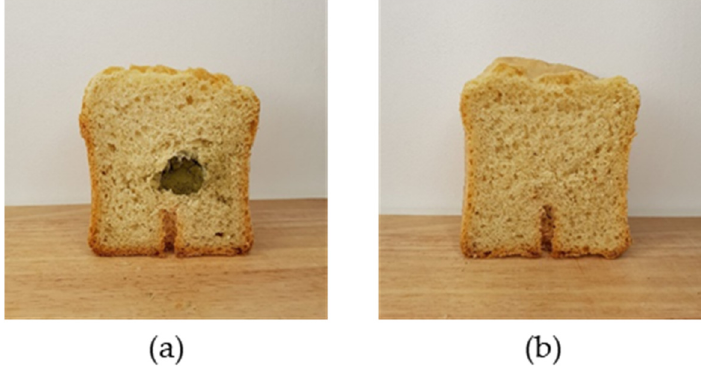
Figure 8. Picture of the cress-enriched model bread. ( a ) with freeze-dried nasturtium ( Tropaeolum majus L, 1.5%) placed as centrally bolus (application No. III); ( b ) Picture of the reference bread without plant material.